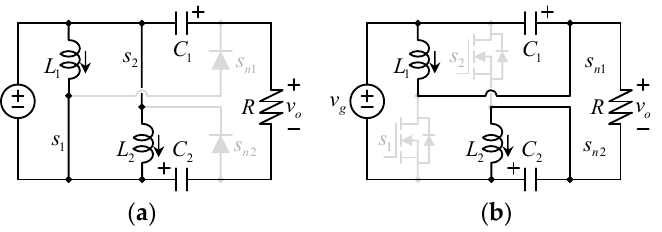
Figure 3. Equivalent circuits, according to the switching state, ( a ) when transistors are closed and ( b ) when transistors are open. ( b ) when transistors are